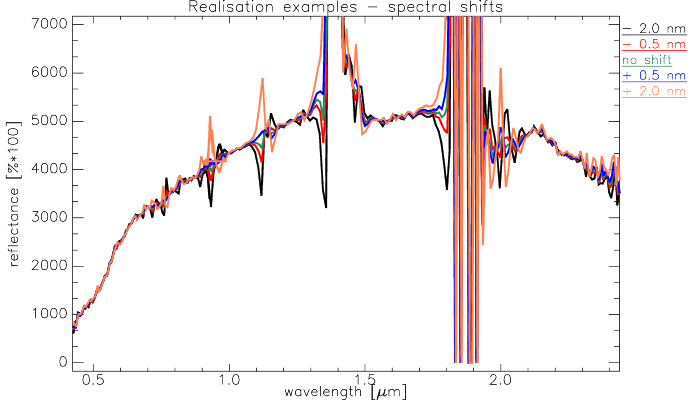
Figure 8. Plot of the reflectance spectra of three realizations of an image pixel, i.e. , having a shift of 0.5 nm towards shorter wavelengths (−0.5 nm), no shift, and a shift of 0.5 nm towards longer wavelengths (+0.5